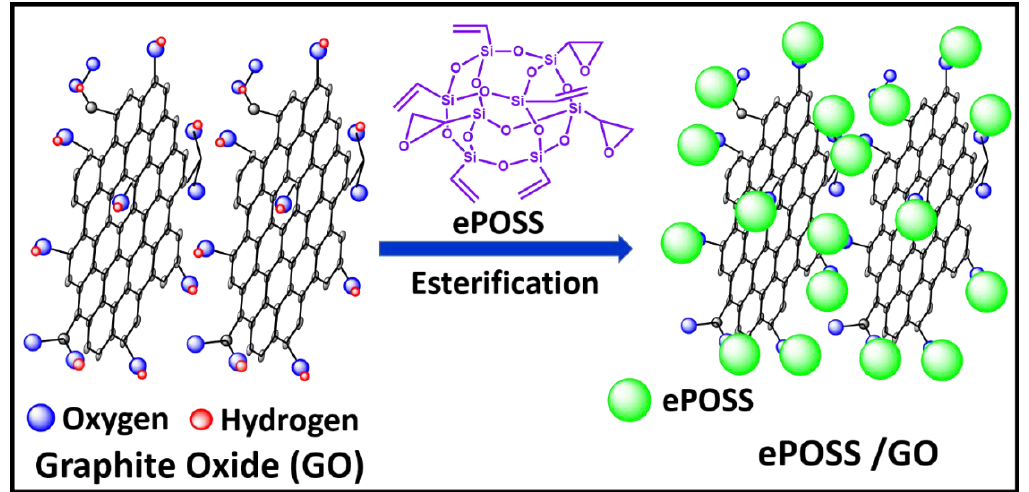
Figure 2. Photographs of the oil-water separation process: ( a ) a membrane fixed between a glass tube and a conical flask with a tilt angle of 45°, ( b ) a mixture of n -hexane (40 mL) and water (40 mL) poured into an upper glass tube and n -hexane passing through the membrane but water repelled, ( c ) hexane collected in a measuring cylinder after separation, ( d – f ) a similar process for separating tetrachloromethane (heavier than water) and water (water dyed with methyl blue). Adopted from Ref. [122].